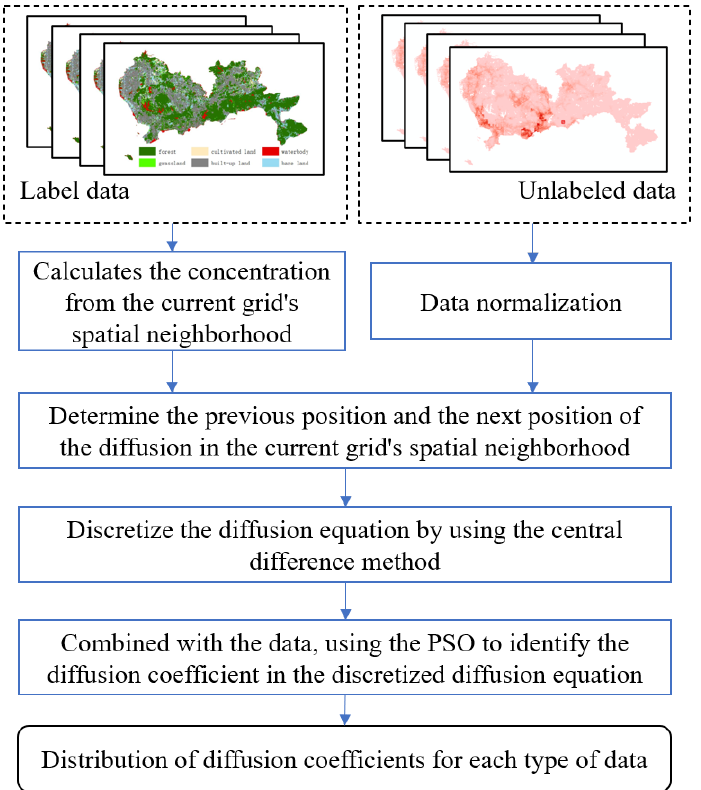
Figure 2. The method flow of using the PSO algorithm to identify the diffusion